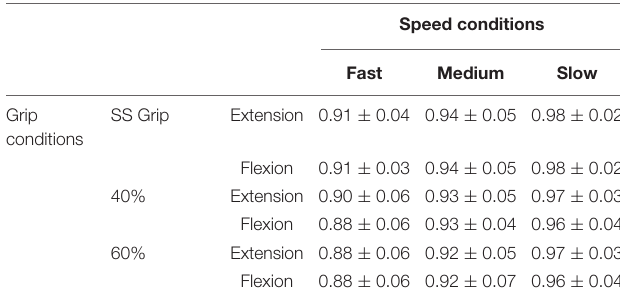
TABLE 2 | Goodness-of-fit ( R 2 ) between the model-generated and experimental torque profiles, evaluated for all subjects belonging to the RH group and performing the nine experimental conditions divided by the direction of the